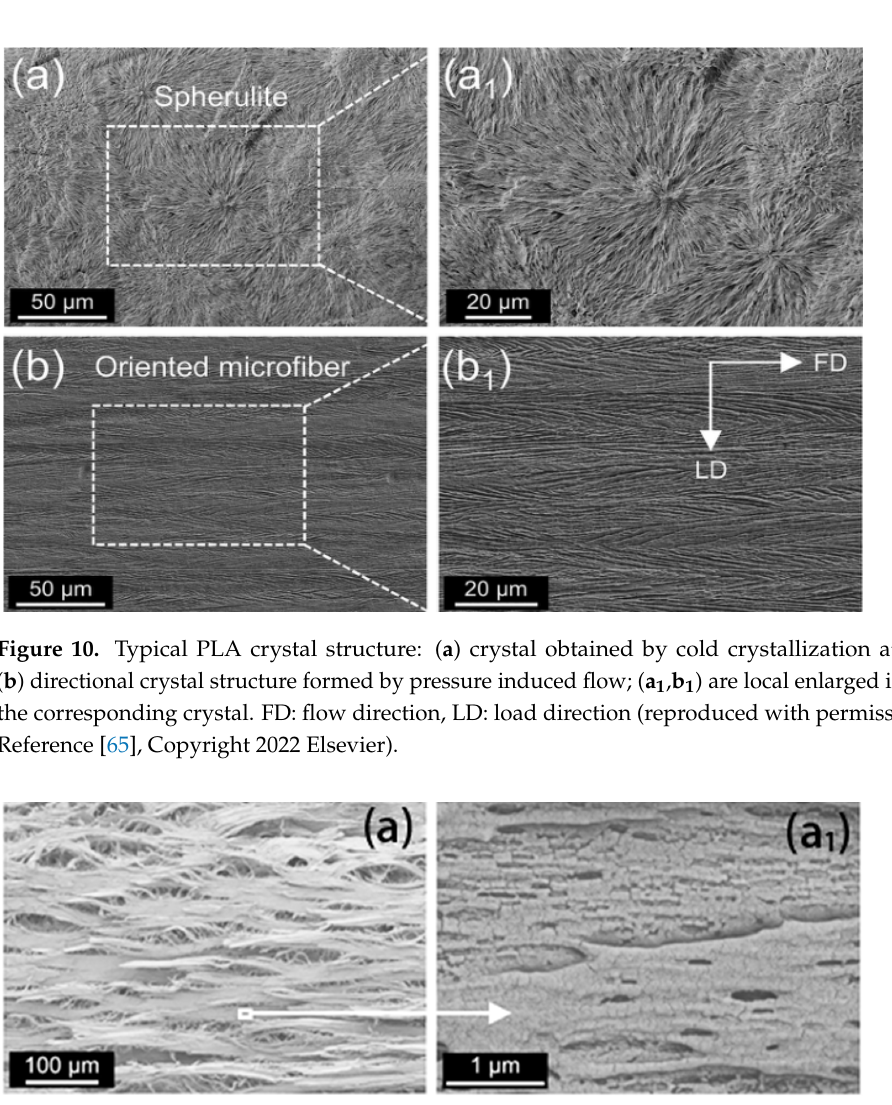
Figure 11. Image of polylactic acid foaming micro/nano bimodal cell structure after pressure induced flow. ( a ) SEM images of nano-sized cells obtained at foaming temperature of 60 °C; ( a 1 ) SEM images of nano-sized cells from the local observation of ( a ) (reproduced with permission from reference [65], Copyright 2022 Elsevier).